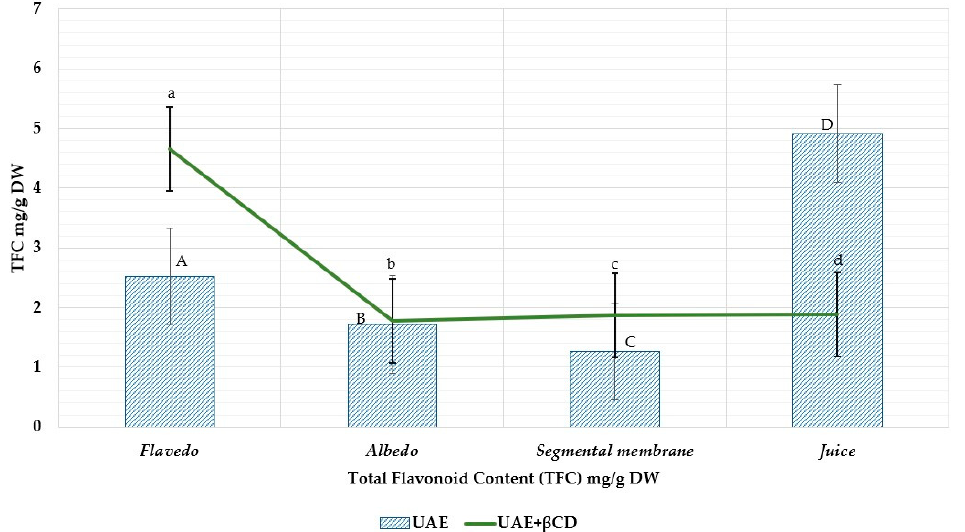
Figure 13. The total flavonoid content (TFC) in grapefruit ethanolic extract with and without β -CDs. A, B, C, D—ultrasound extraction method (UAE), a, b, c, d—ultrasound extraction method (UAE) + β -CDs. The result is the mean value ( n = 3) a, b, c, d p < 0.05 vs. A, B, C,